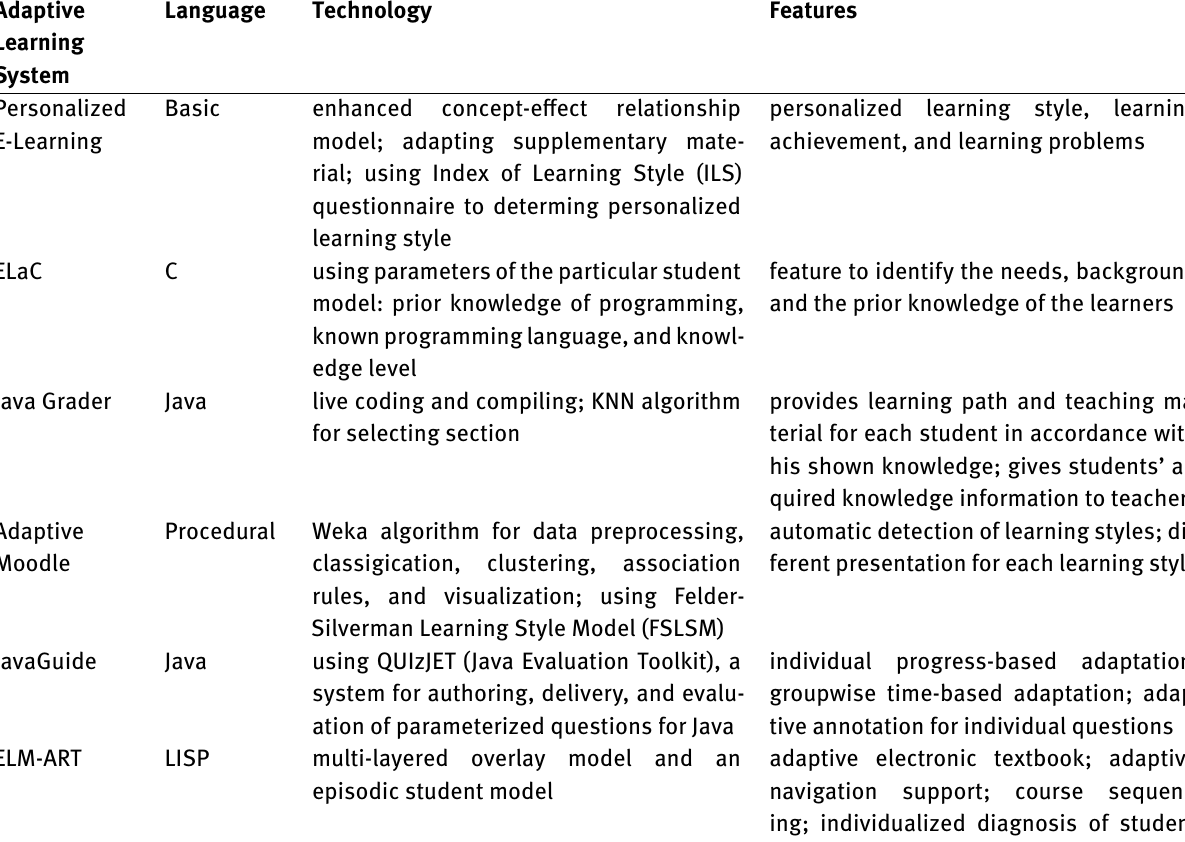
Table 4: Programming language, technology, and features for each adaptive learning system